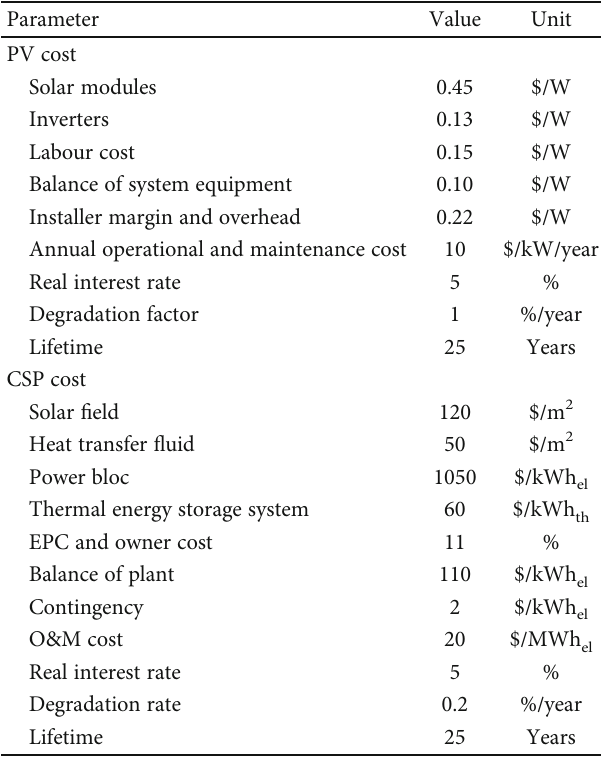
Table 1: Financial parameters for PV and CSP plants